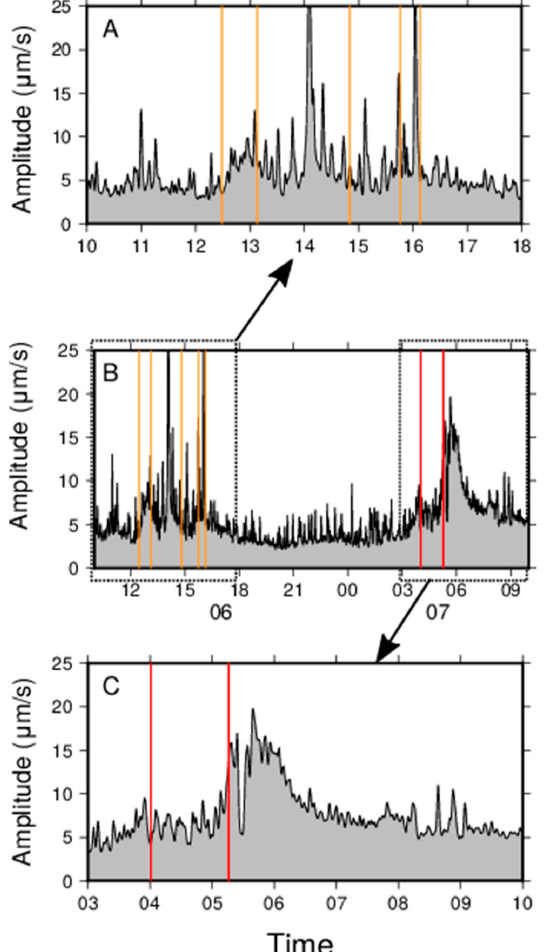
Figure 7. Plot of the high-frequency (>10 Hz) seismic amplitudes averaged over 10 s windows (station STR8, EW seismic component) for: ( A ) details referred to the time interval 10:00–18:00 of 6 August 2014, highlighting the signals associated with landslides that occurred soon after the onset of the overflows, whose onset is marked by orange vertical lines; ( B ) the time interval 10:00 on 6 August 2014–10:00 on 7 August 2014; ( C ) details referred to the time interval 03:00–10:00 of 7 August 2014, highlighting the signals associated with landslides that occurred at the opening V1 and V2 vents (red vertical lines).